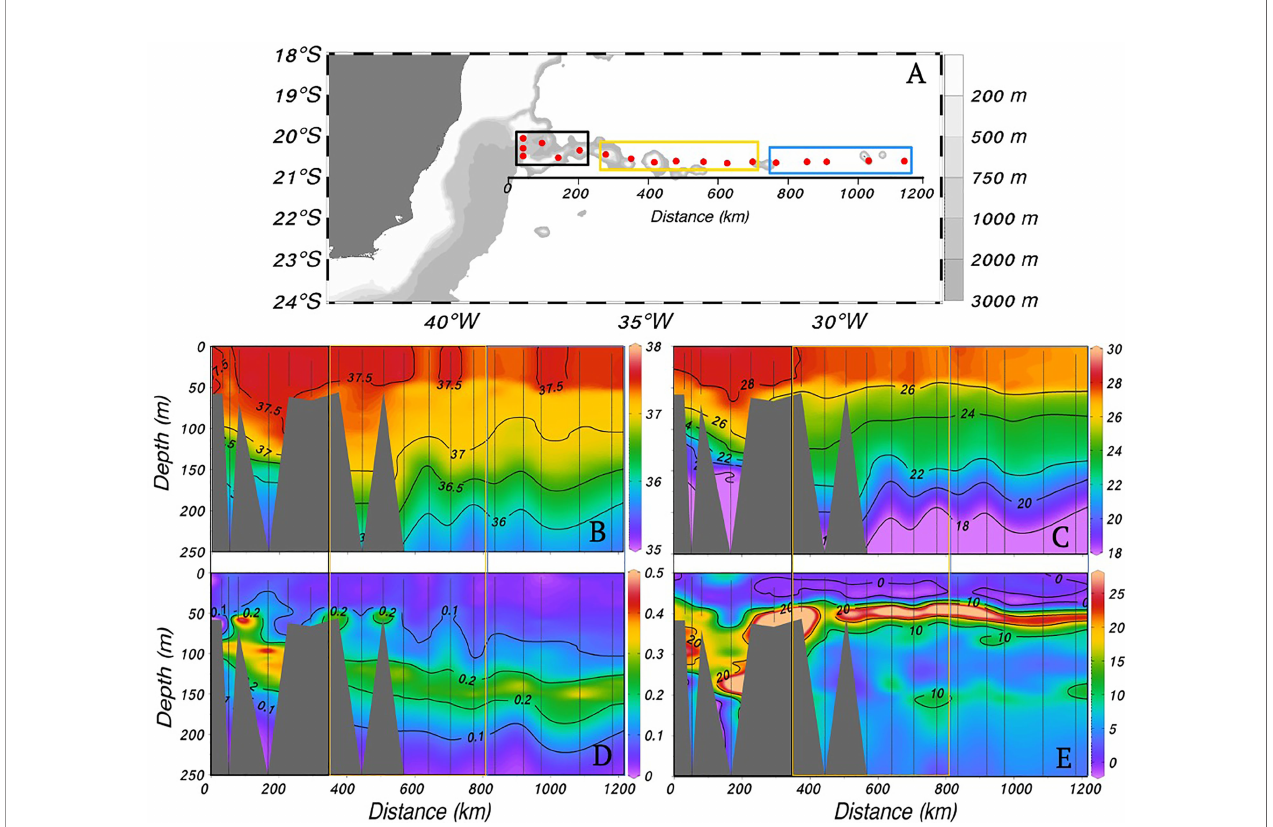
FIGURE 2 | (A) Map of station locations in the western South Atlantic. (B-E) Depth pro fi les in the upper 250 m along a transect (approximately 20°S) during February 2017: (B) salinity, (C) temperature (°C), (D) chlorophyll concentration from the CTD fl uorometer (mg m -3 ), and (E) Brunt-Vaisala frequency (× 10 -5 rad 2 s -2 ). The rectangles show the three sectors (West, Middle, and East) derived from a hierarchical cluster analysis of the physical parameters. In panels B-E, vertical black lines indicate the station